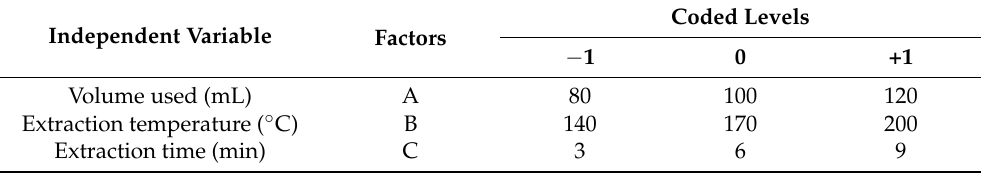
Table 1. Independent process variables, range and levels used for Box–Behnken design. Independent